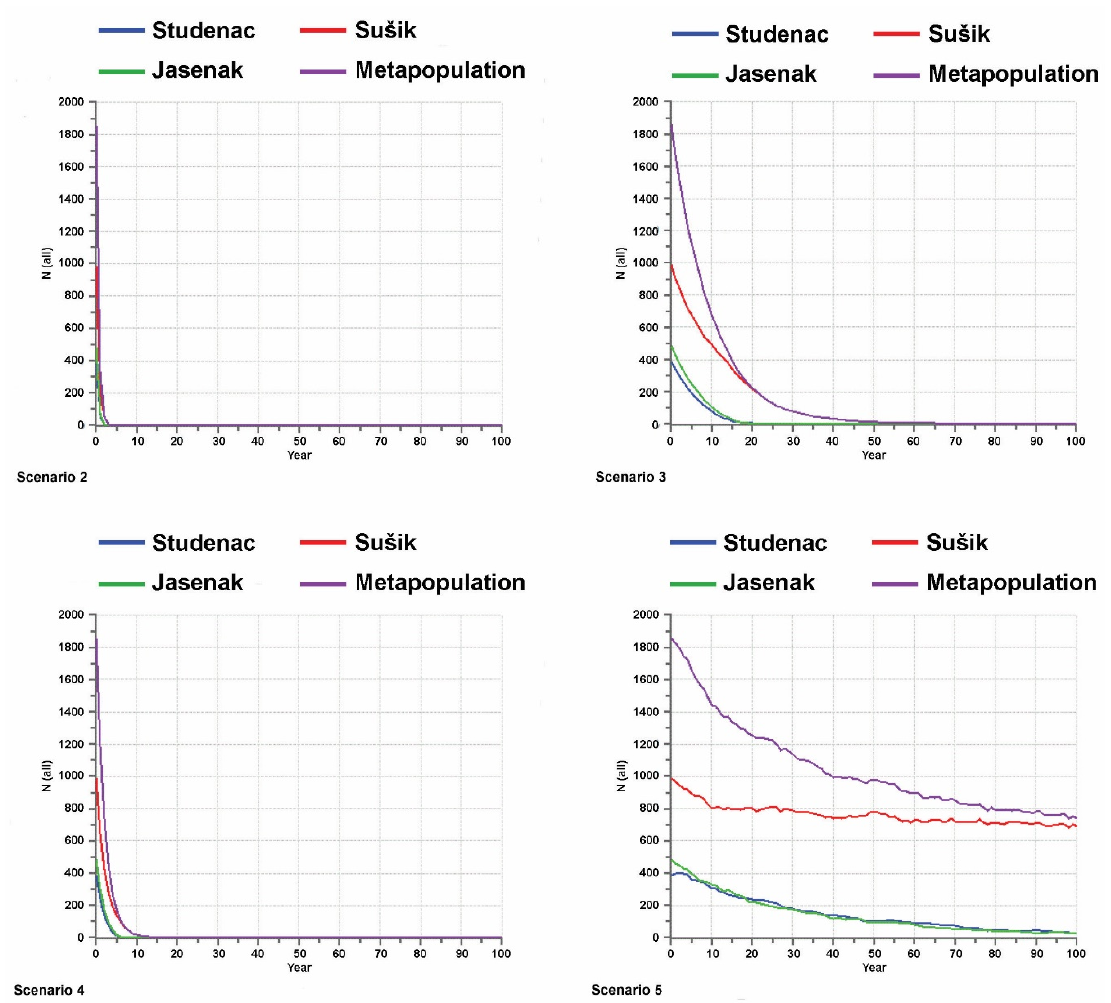
Figure 5. Results of population viability analyses for T. karsticus based on six scenarios.